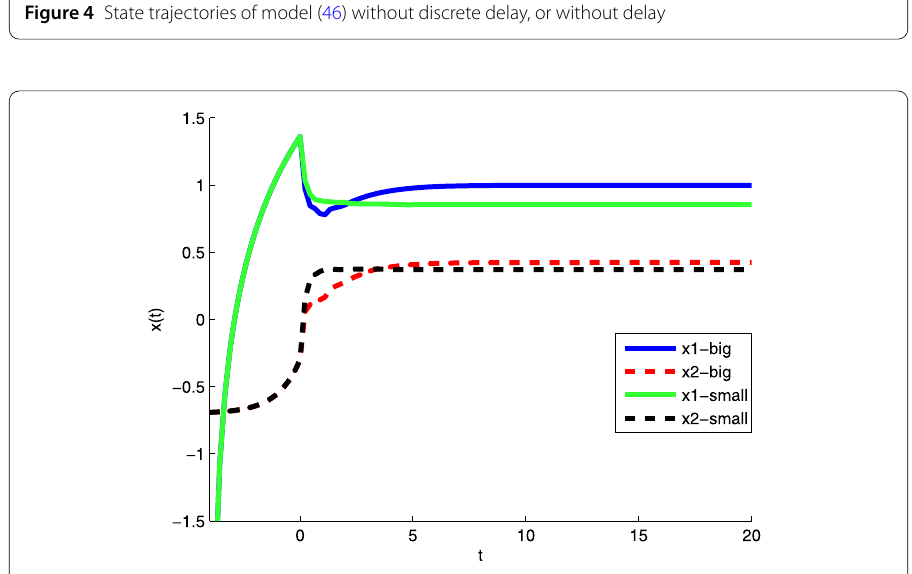
Figure 5 State trajectories of model (46) with different asynchronous time-varying